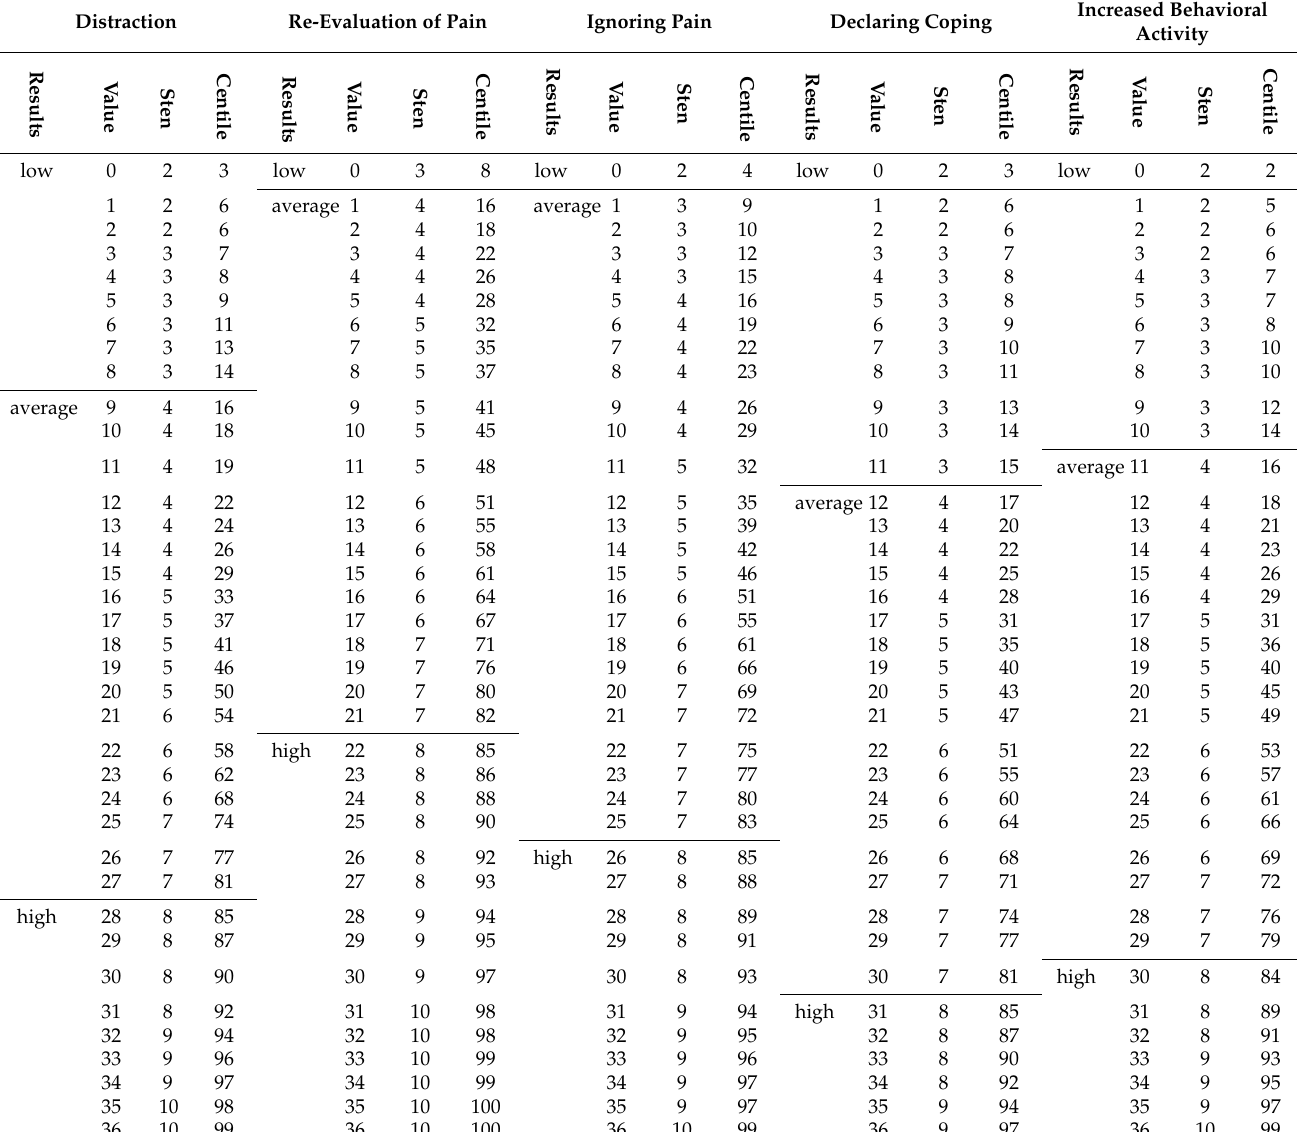
Table 5. Raw results and corresponding normalized results for distraction, re-evaluation of pain, ignoring pain, declaring coping, and increased behavioral activity in the entire sample